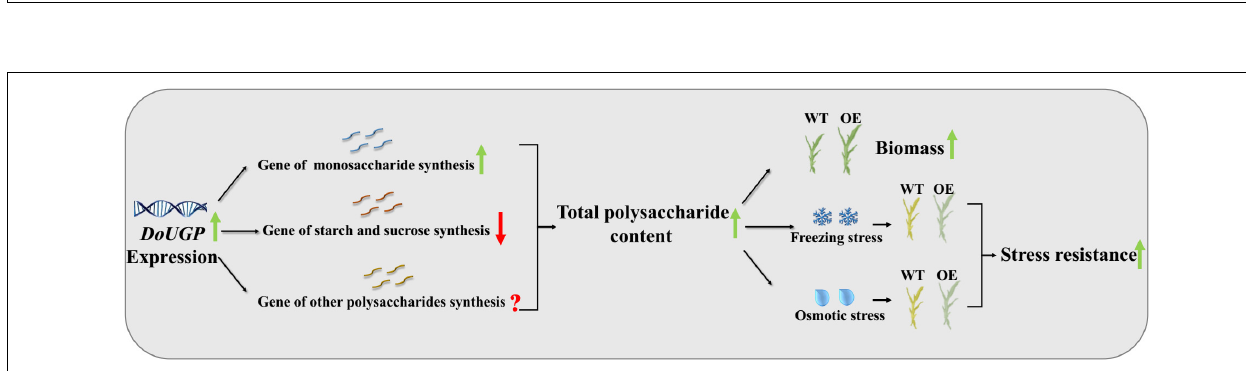
Frontiers in Plant Science |